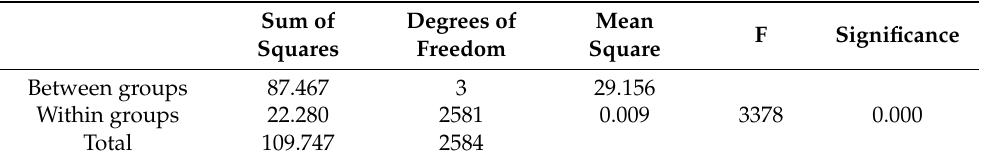
Table A3. Statistical analysis of ANOVA for the key wavelength of 783 nm for the four excess nitrogen treatments.